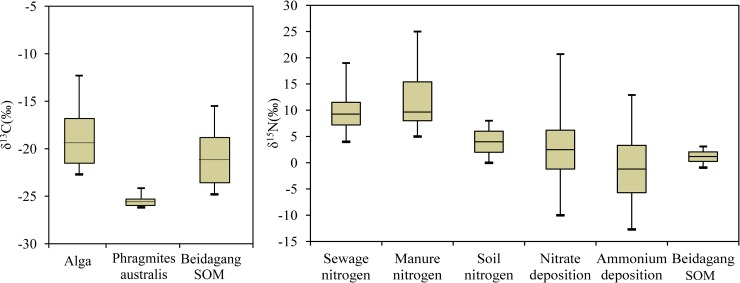
Box plots of δ13C and δ15N values from various sources.The lower and upper edges of the box represent 25th and 75th percentiles, encompassing the mean value (line); the lower and upper bars represent 10th and 90th percentiles. (Data from the references [28–30]; data in Beidagang SOM from the present study).